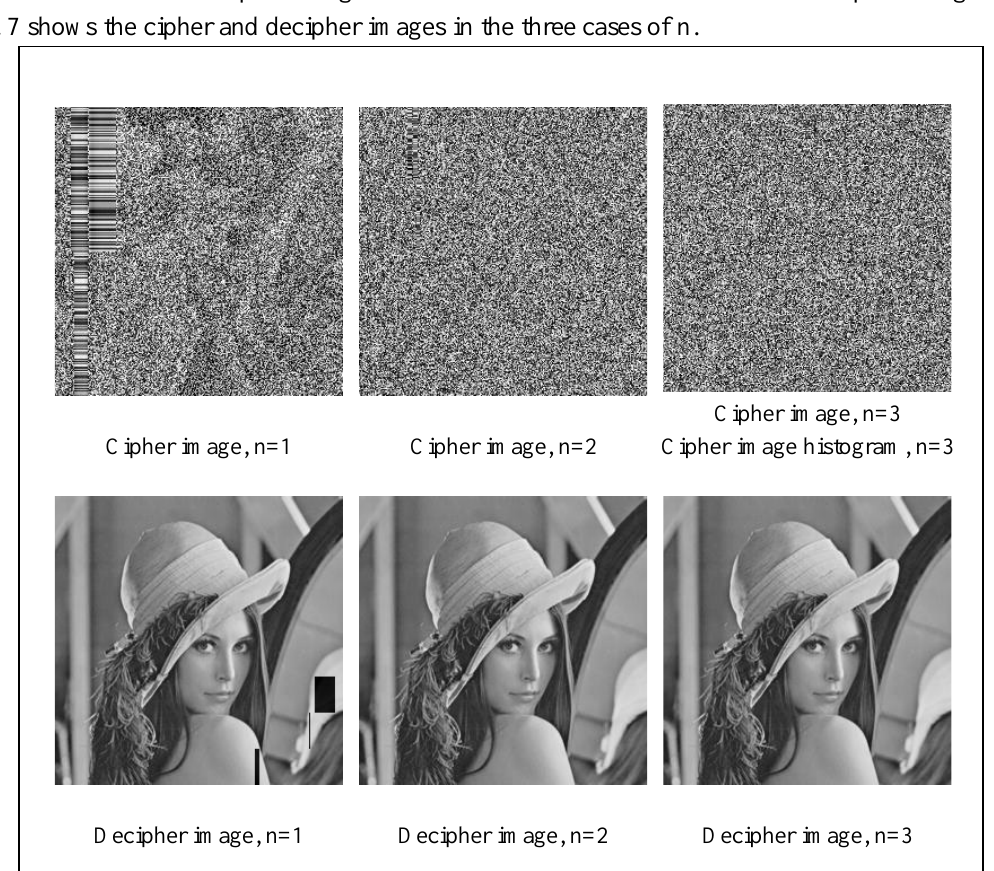
Figure 7. "Lena.png" cipher and decipher images in all the case of n The correlation coefficients of 2000 random pixels on horizontal, vertical, and diagonal are listed in Table 5. The correlation coefficients of the cipher images were close to 0, which means that the adjacent pixels are highly décorrelated to each